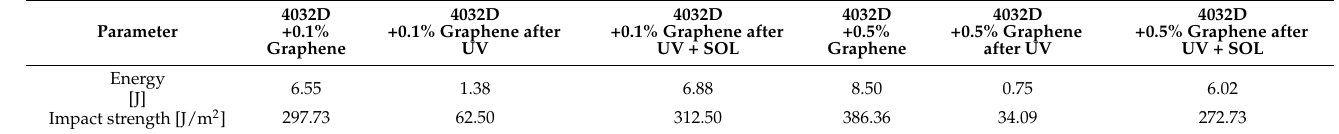
Table 5. Values of energies and impact coefficients for samples 4032D admixed with GNP. 4032D Parameter +0.1%